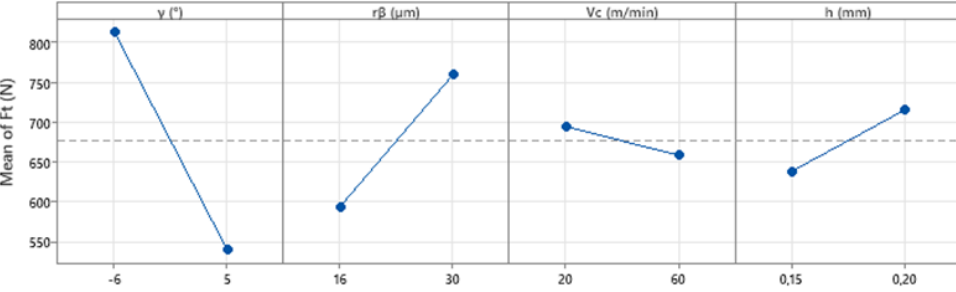
Figure 7. Influence of the cutting parameters on the thrust force ( F t ) based on all cutting conditions.